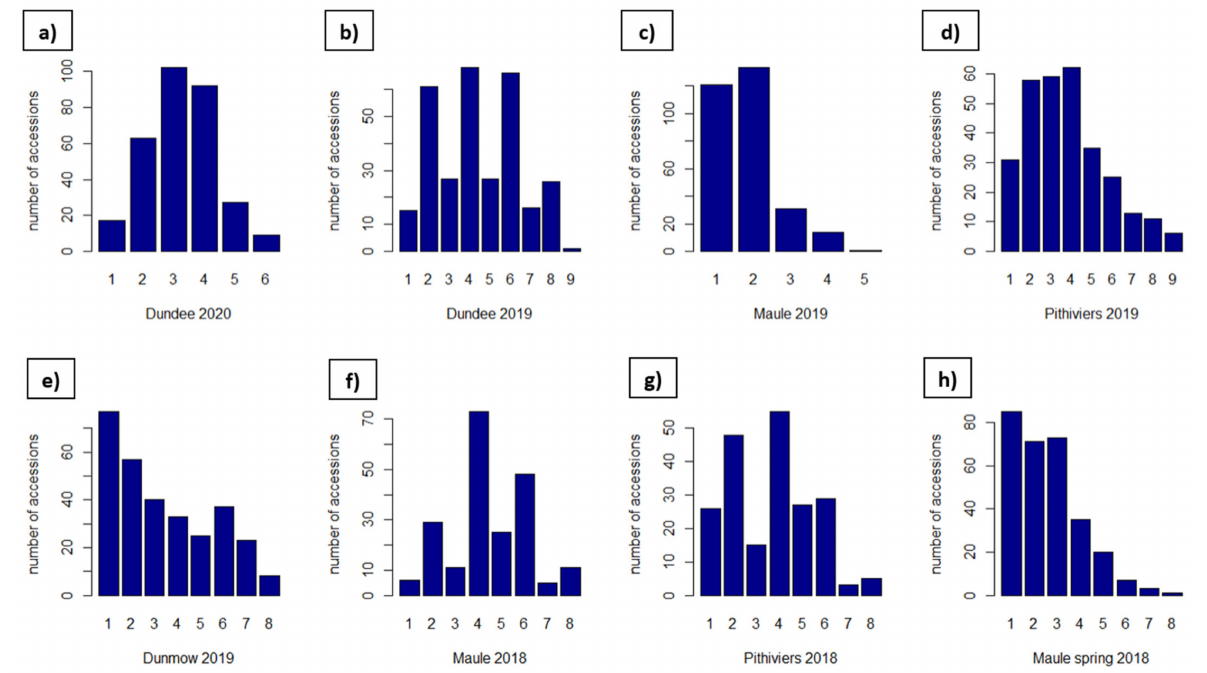
Figure 2. Histograms representing the distribution of the rhynchosporium scores within the eight field trials, on a 1–9 scale, where 1 = no symptoms and 9 = all leaves infected. The field trials are ( a ) Dundee 2020, ( b ) Dundee 2019, ( c ) Maule 2019, ( d ) Pithiviers 2019, ( e ) Dunmow 2019, ( f ) Maule 2018, ( g ) Pithiviers 2018, ( h ) Maule spring sowing